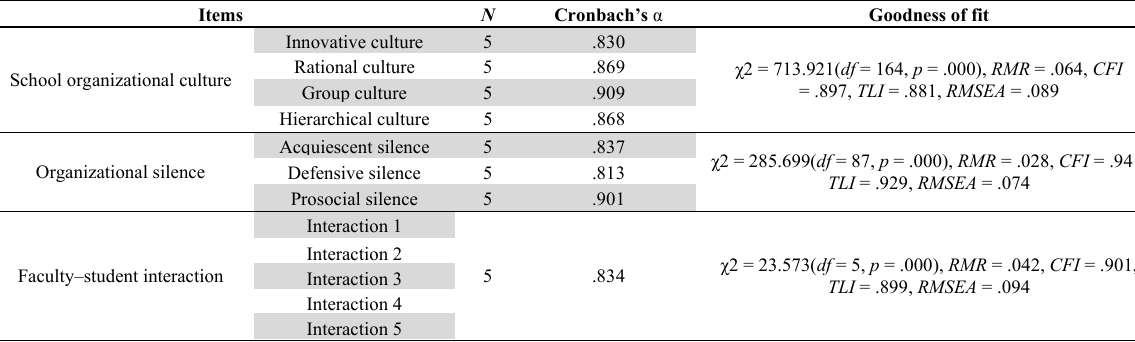
Reliability and